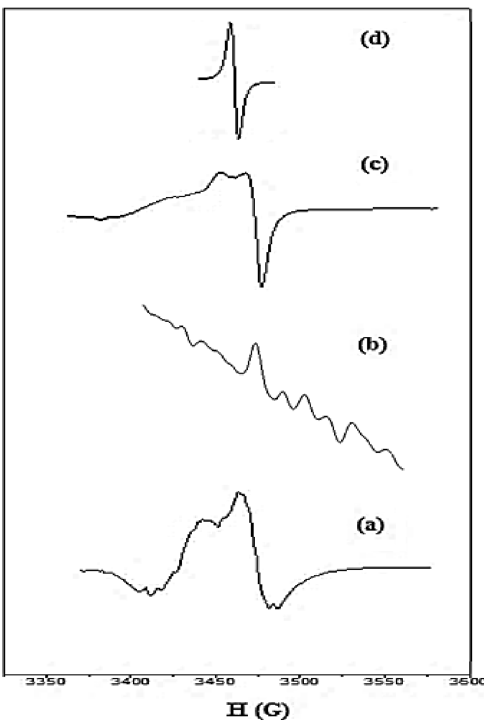
Figure 5. X-band ESR spectra of Mn(II) complex 2 ( a ), Co(II) complex 3 ( b ), Cu(II) complex 5 ( c ), and the standard (DPPH) ( d